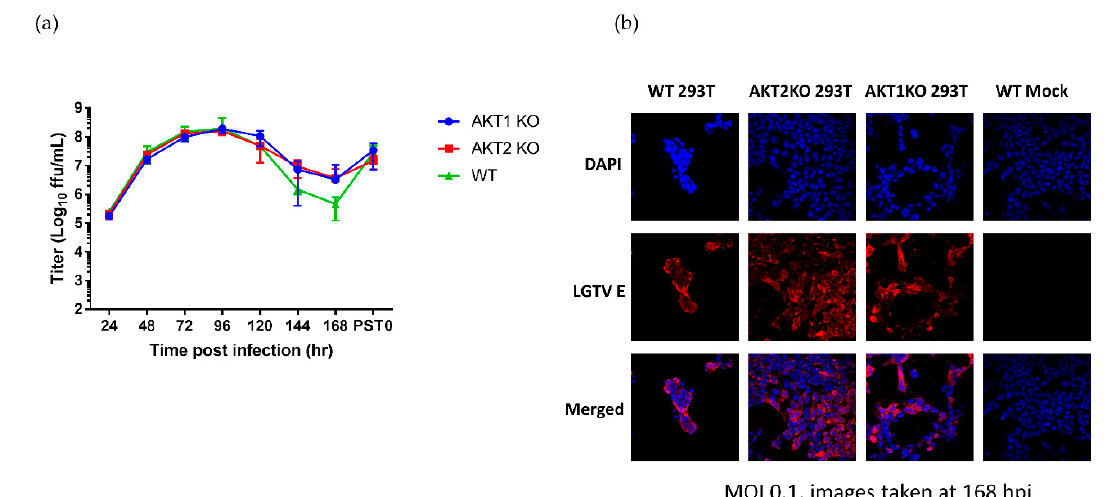
Figure 5. LGTV-infected AKT knockout cells enter viral persistence without substantial alteration in viral replication. AKT1 KO, AKT2 KO, and WT 293T cells were infected with LGTV at an MOI of 0.1. ( a ) Viral titers of acute and persistently infected AKT KO and WT cell lines. Error bars indicate standard deviation from three independent experiments. ( b ) Immunofluorescence analysis evaluating expression of the viral E protein (red), a proxy for infection, at 168 hpi. Nuclei were counterstained with DAPI (blue). Images were taken with a 40× objective.